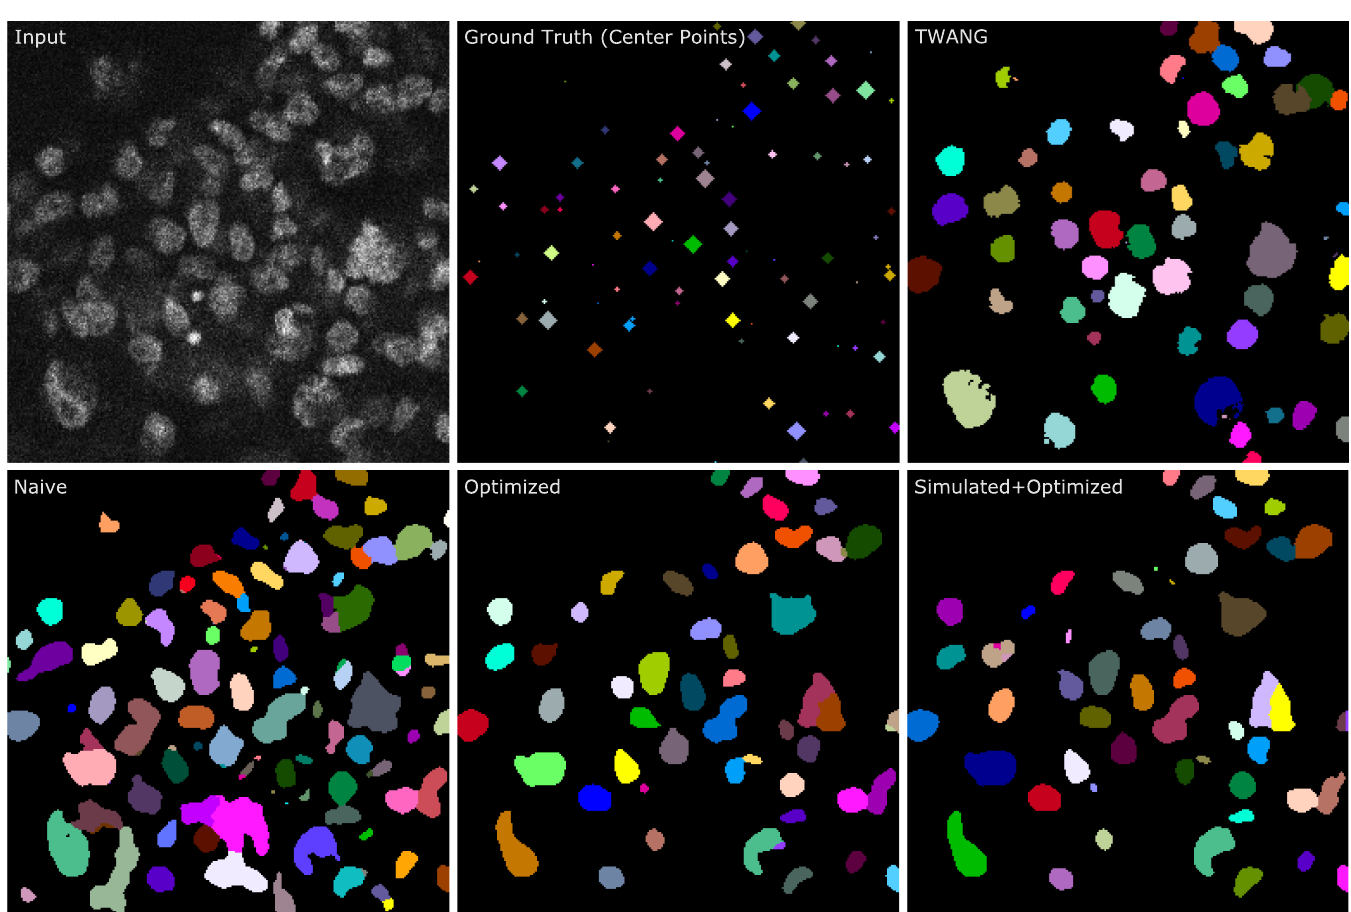
Fig 7. Zoomed 2D slices of a real image (upper left, Input), the corresponding ground truth (upper, middle, center point annotations) and segmentation results. As segmentation methods, the classical algorithm TWANG and deep learning algorithms trained with naive, optimized, and the combination are used as indicated. The center point annotations are enlarged by five repeated morphological dilation operations with a diamond shaped structuring element. The size of the center points therefore corresponds to their distance to the shown slice.